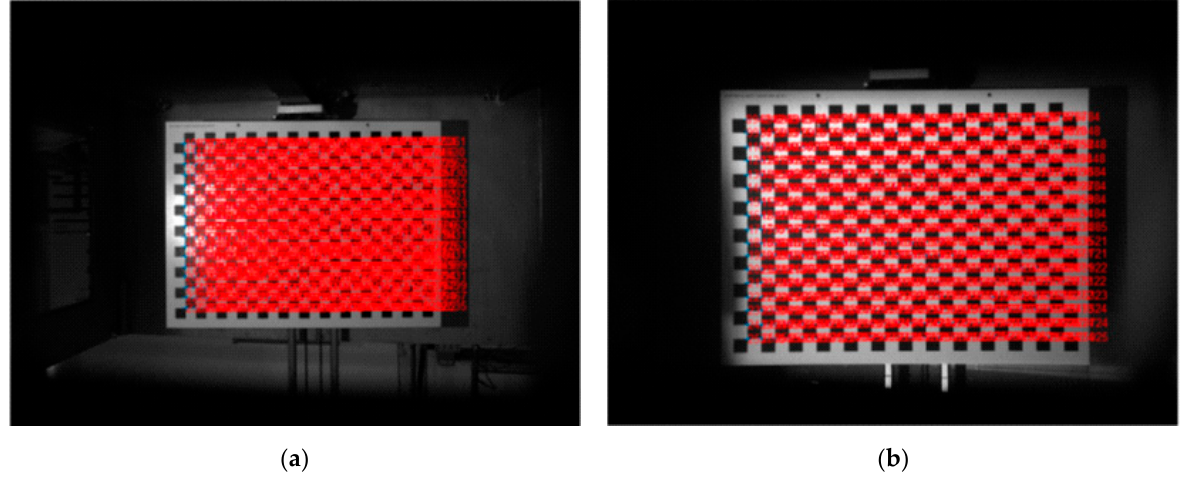
Figure 19. Results of checkerboard detection: ( a ) air; ( b ) water.